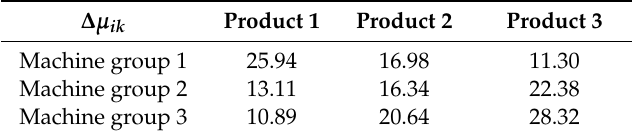
Table 7. The supplementary production capacities in the machine groups for the product types.